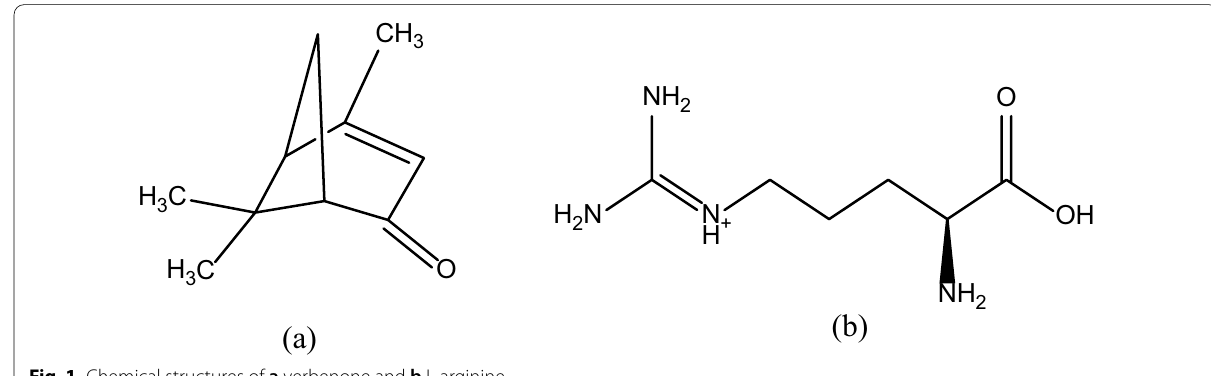
Fig. 1 Chemical structures of a verbenone and b